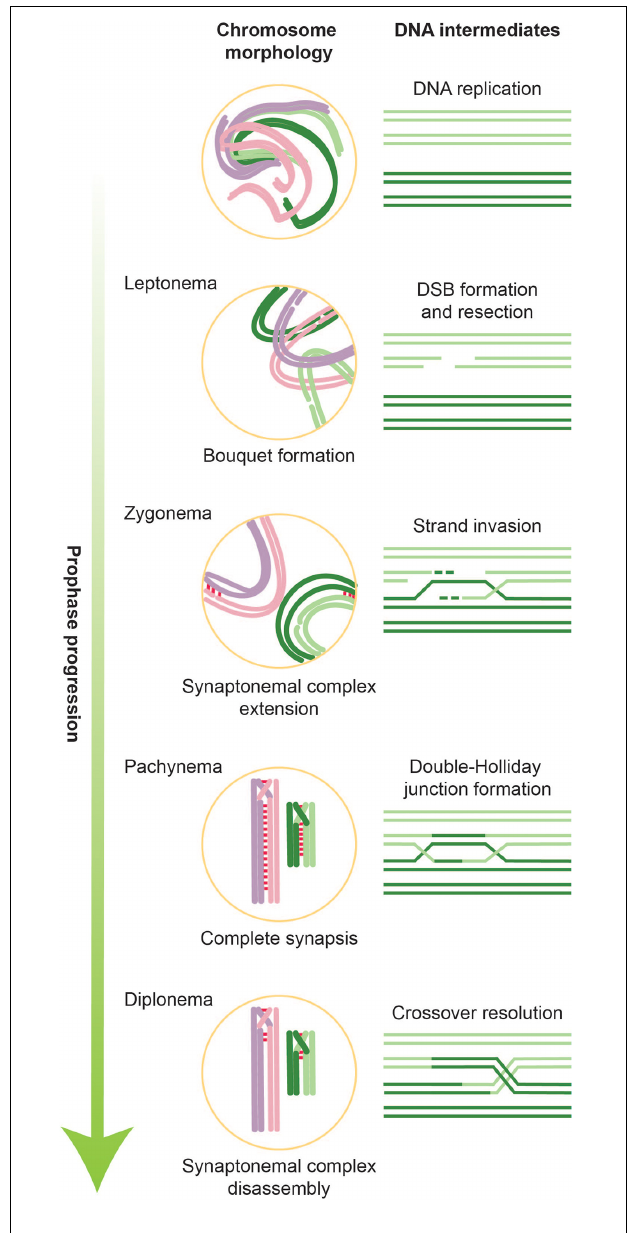
FIGURE 1 | Overview of stages of meiotic prophase along with corresponding DNA intermediates. During leptonema, the first stage of meiotic prophase, chromatin condenses and forms attachments with the nuclear envelope. It is also during this stage that DSBs are introduced. In parallel with ongoing DNA repair, homologous chromosomes pair and formation of the SC is initiated. Partial SCs define the next meiotic stage, zygonema. When all chromosomes are synapsed along their axes, cells are in pachynema, which is when the bulk of double-Holliday junctions form. During late pachynema/early diplonema, double-Holliday junctions are resolved into crossovers and SC disassembly begins. Cells then exit meiotic prophase and prepare for the first meiotic